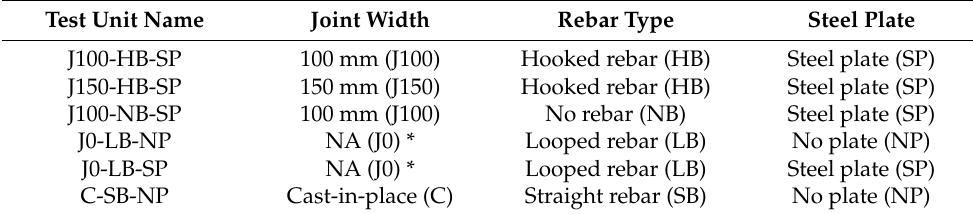
Table 1. Test parameters.